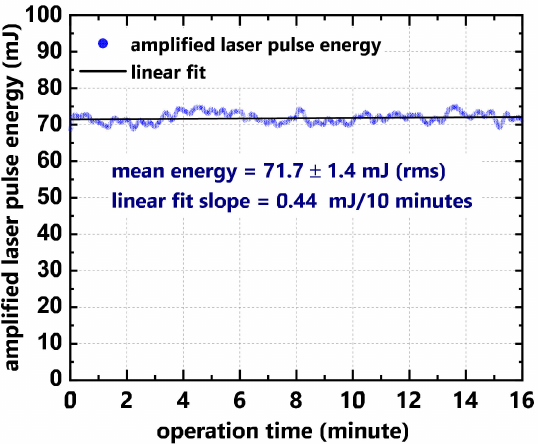
Figure 4. Measurement of the amplified laser pulse energy at a repetition rate of 10 Hz for more than 15 min. The measured energy shows 71.7 ± 1.4 mJ (rms), and the energy drift is 0.44 mJ/10 min.